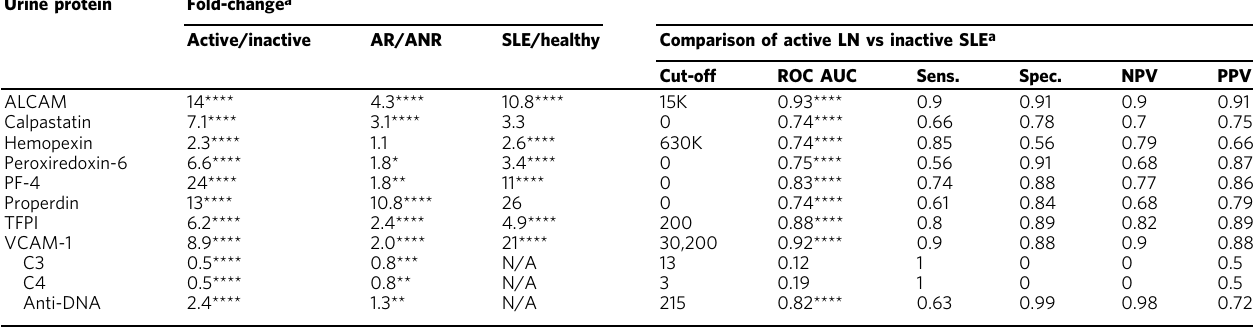
Table 5 Urine Cr-normalized biomarkers in the second (Chinese) validation cohort. Urine protein Fold-change a Active/inactive SLE/healthy Comparison of active LN vs inactive SLE